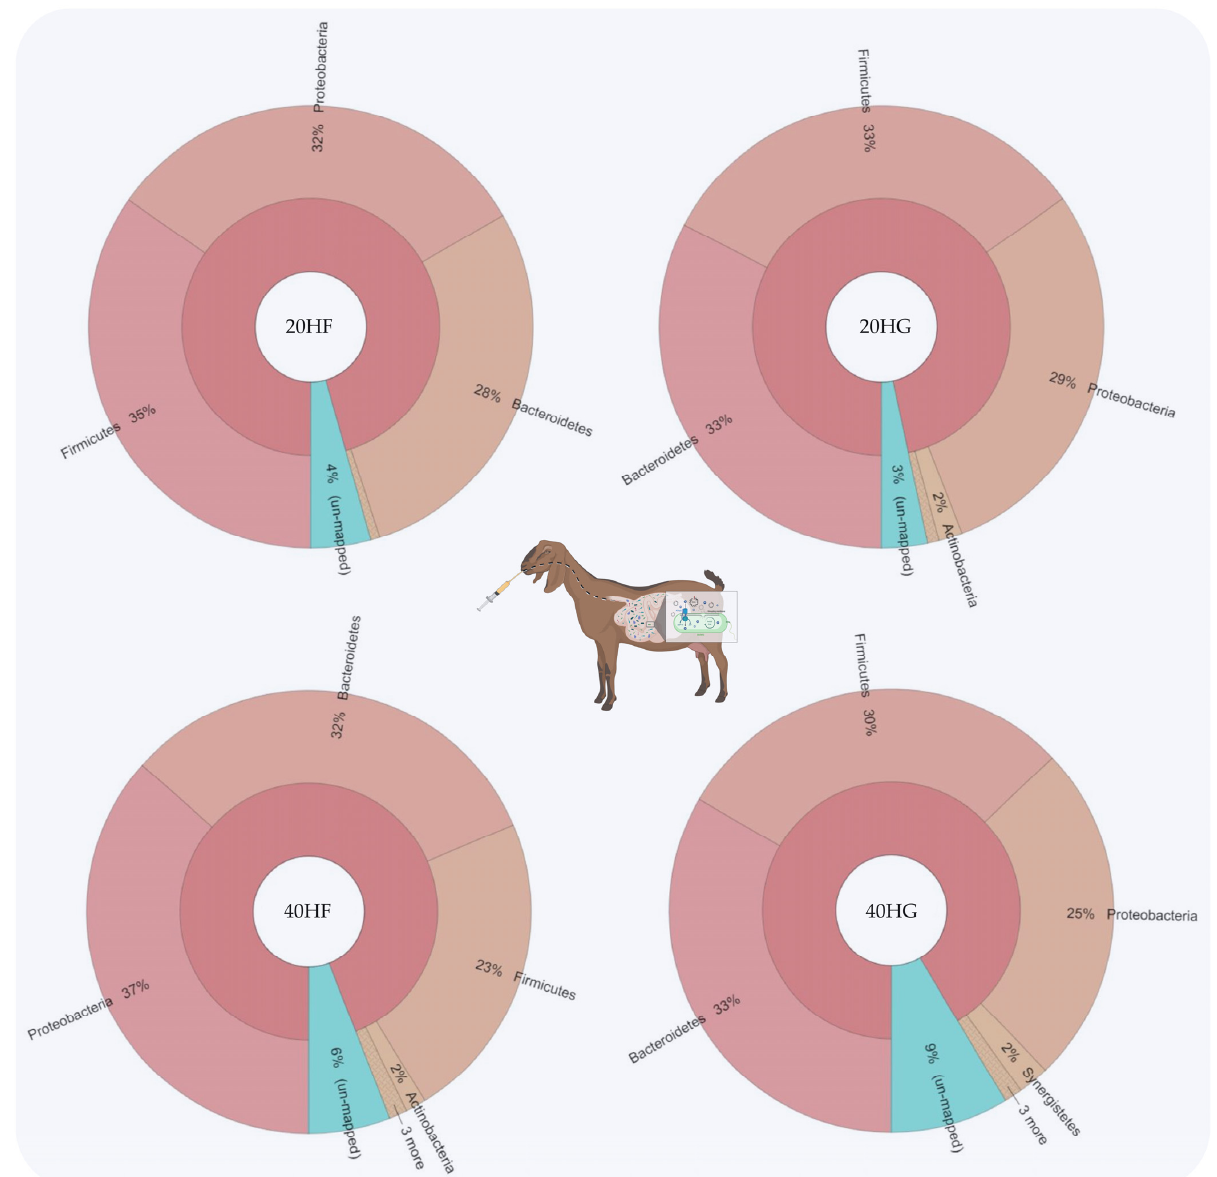
Figure 1. Relative abundance of the most abundant phyla in rumen fluid of goats fed diets (20HF, 20HG, 40HF, and 40HG) with different levels of Schizochytrium spp. (20 g and 40 g/goat/day) and two different forage to concentrate ratios (60:40 and 40:60) throughout the experimental period (21 and 42 experimental days) illustrated using Krona software. Additional statistics are available in Table S3.